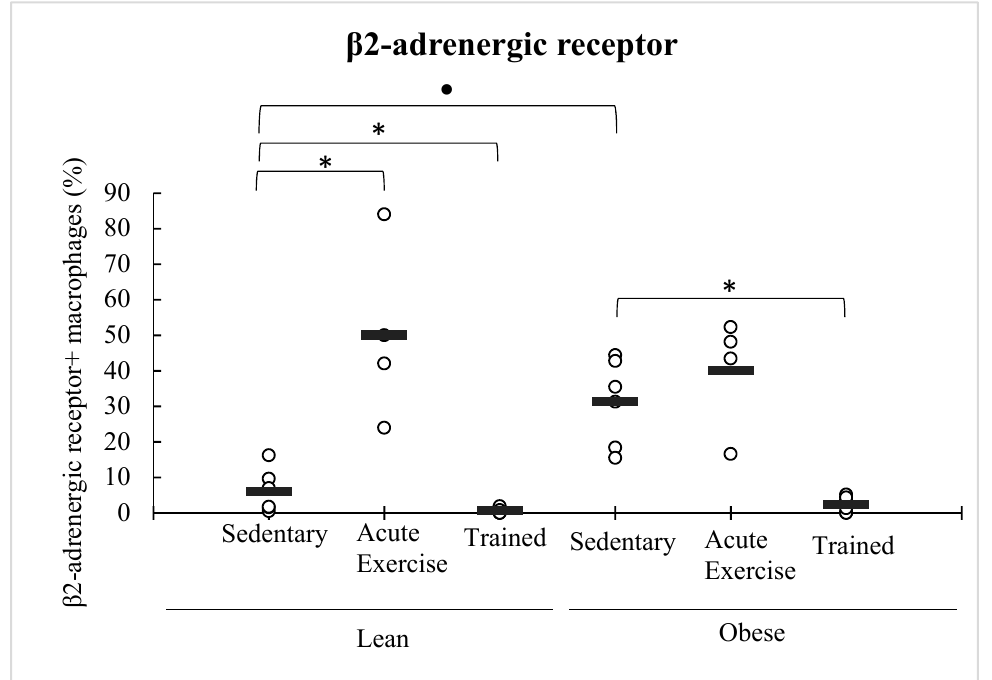
Figure 5. Effect of exercise on the expression of β 2-adrenergic receptor in peritoneal macrophages from lean and obese mice (sedentary, acute exercise, and trained mice). Each dot represents the individual values obtained in duplicate in each animal, and the horizontal line represents the mean. * p < 0.05 with respect to the corresponding sedentary group; ● p < 0.05 with respect to the lean sedentary group.